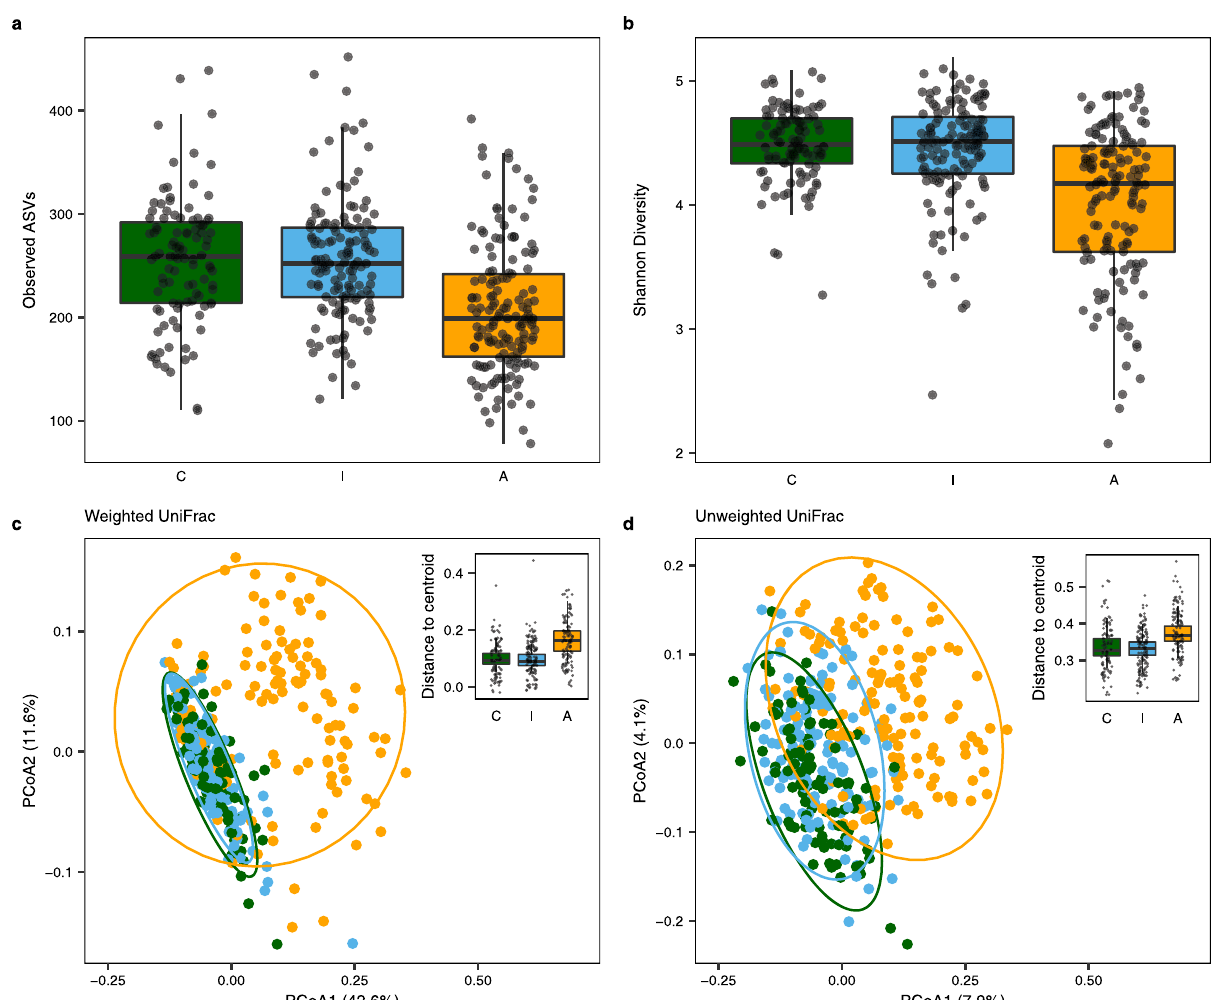
Fig. 1 Additional anthropogenic disturbance in fl uences gut microbial diversity and structure in the generalist spiny rat P. semispinosus . a , b Gut microbial alpha diversity within spiny rat individuals inhabiting protected, continuous forests (control landscape C, green, n = 103 individuals), protected, isolated forest fragments (islands) with no further anthropogenic disturbance (landscape I, blue, n = 136 individuals), and forest fragments embedded in an agricultural matrix with additional anthropogenic disturbance (landscape A, orange, n = 145 individuals). Alpha diversity is measured by a the observed number of ASVs (i.e., ASV diversity) and b Shannon diversity, which also accounts for species abundance. Boxplots display the median with the center line, hinges represent 25th and 75th percentiles, and whiskers extend to 1.5 times the interquartile range. Each dot represents a sampled spiny rat individual. c , d Principal coordinates analysis (PCoA) plots of the diversity between spiny rat individuals accounting for phylogenetic diversity and weighted ( c ) and unweighted ( d ) for abundance using UniFrac distances. Each dot represents a P. semispinosus individual sampled in landscape C (green), landscape I (blue), or landscape A (orange). Sample sizes in the PCoA plots equal to a and b . Ellipses indicate 95% con fi dence intervals. Inset boxplots show the weighted ( c ) and unweighted ( d ) UniFrac distances to the study site centroids within each landscape ( n = 89 individuals in C, n = 126 individuals in I, n = 107 individuals in A). Boxplot parameters the same as in a and b